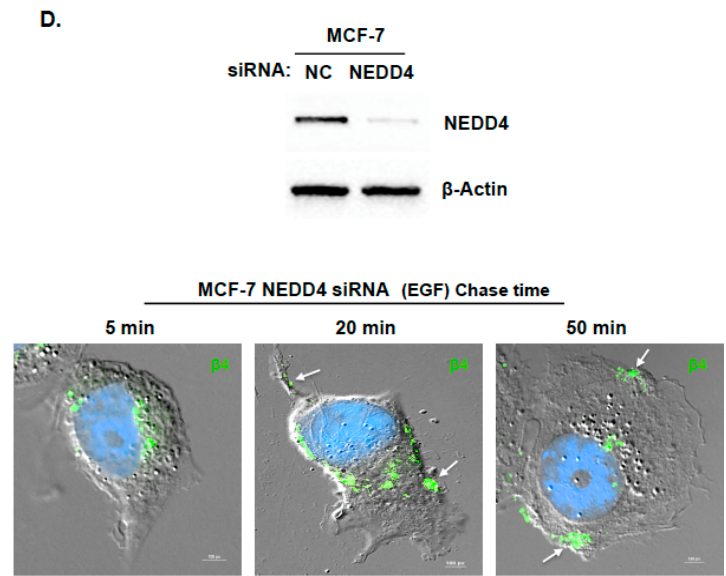
Figure 4. ARRDC3 mediates NEDD4 dependent ITG β 4 ubiquitination by serving as an adaptor molecule between NEDD4 and ITG β 4. ( A ) Endogenous ITG β 4 was immunoprecipitated in MDA-MB-231 cells transfected with HA-NEDD4, followed by IB with HA (left panel). MDA-MB-231 cells were transfected with HA-empty and HA-NEDD4. IP was performed with HA trap beads, followed by IB with ITG β 4 (right panel). ( B ) NEDD4 knockdown MD-MB-231 cells by shRNA were co-transfected with HA-Ub and either ITG β 4-Myc or Myc-empty vector. Ubiquitination was analyzed by IP with Myc trap beads and IB with HA antibody. Input: whole cell lysate. ( C ) MDA-MB-231 cells were co-transfected with GFP or GFP-ARRDC3 and HA or HA-NEDD4. IP was performed with HA trap beads, followed by IB with ITG β 4, HA and GFP antibodies. ( D ) MCF-7 cells were transfected with siRNA negative control (NC) and siRNA NEDD4. After 48 h, the knockdown was evaluated by Western blotting with NEDD4 and β -Actin antibodies (Top). Immunofluorescence-based ITG β 4 recycling assay were performed in NEDD4 knockdown MCF-7 cells as described in materials and methods. Immunofluorescence signals of ITG β 4 (green) were captured by a fluorescence microscope with DIC optic (bottom). Scale bar: 100 µ m. All experiments were repeated at least three times.